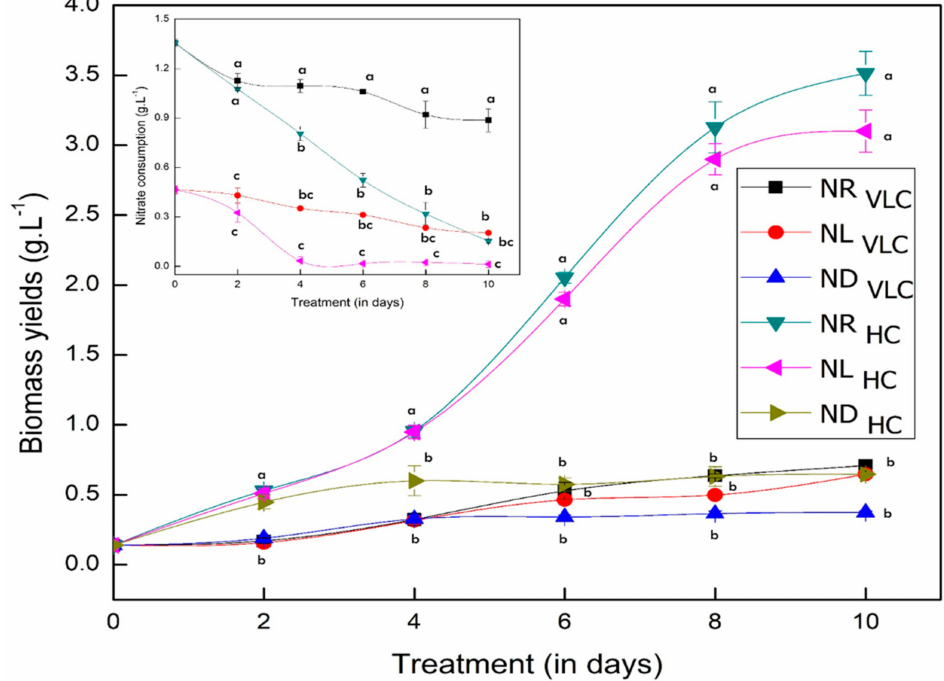
Figure 1. Line diagram indicating biomass yields (in g · L − 1 ) of the native isolate Monoraphidium sp. CABeR41 subjected to NR VLC , NL VLC , ND VLC , NR HC , NL HC , and ND HC conditions with nitrate consumption rates (represented as inset in g · L − 1 ). Values are the mean average ( n = 3) ± S.E.; different lowercase letters indicate the statistical significance by two-way ANOVA with p -value < 0.05 using post hoc analysis by Tukey’s honestly significant difference (HSD). Table 1. Comparison of various parameters on the 10th day of cultivation, i.e., biomass yields, productivities, and photosynthetic efficiency subjected to NR VLC , NL VLC , ND VLC , NR HC , NL HC , and ND HC conditions in the native isolate Monoraphidium sp. CABeR41. Values indicated are mean average ( n = 3) ± S.E.; different lowercase letters indicate the statistical significance by two-way ANOVA with p -value < 0.05 using post hoc analysis by Tukey’s honestly significant difference (HSD). Parameters NR VLC NL VLC ND